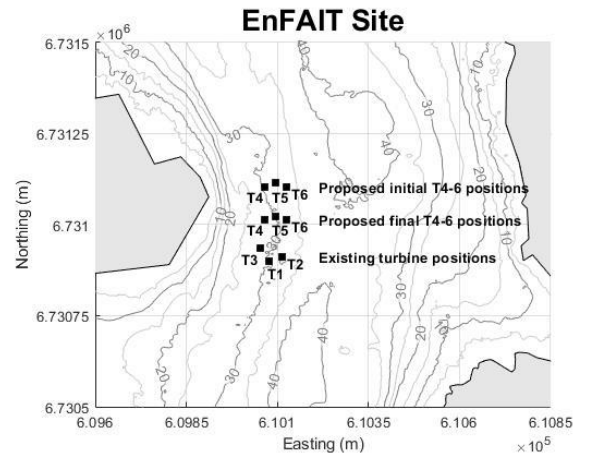
Figure 1. Locations of existing turbines (T1-3) in Bluemull Sound and proposed initial and final positions of T4-6, overlaid on site bathymetry depth